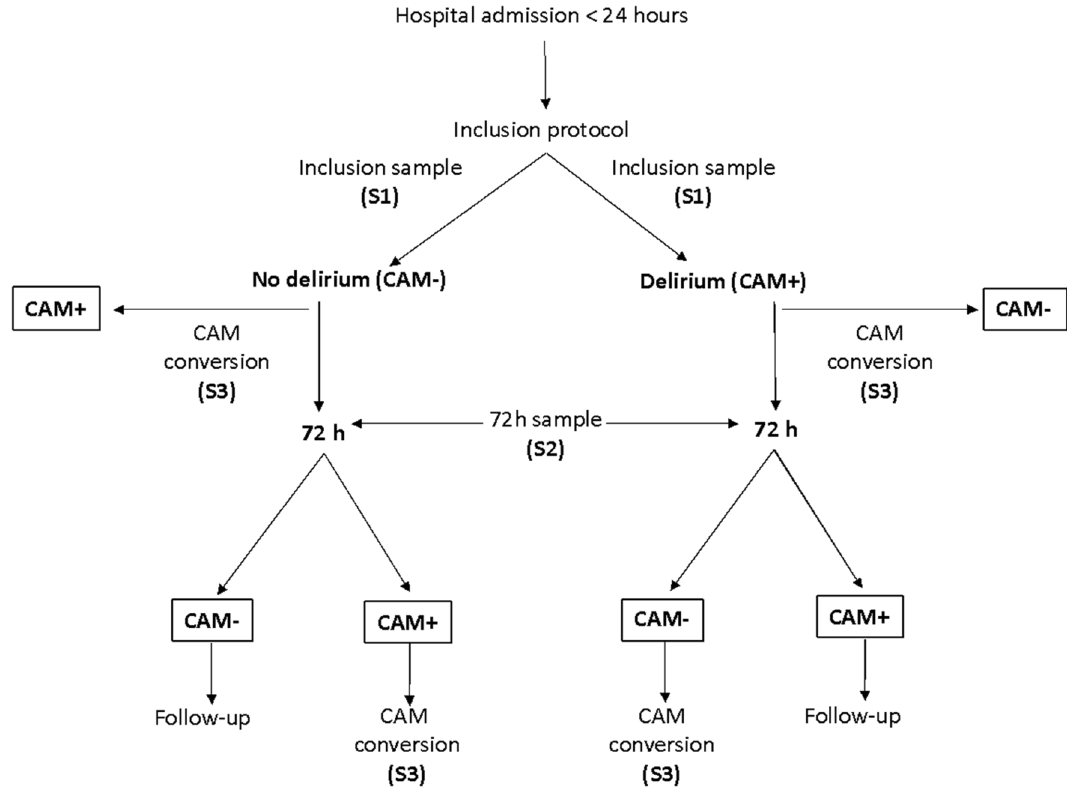
Figure 1. Flowchart of study